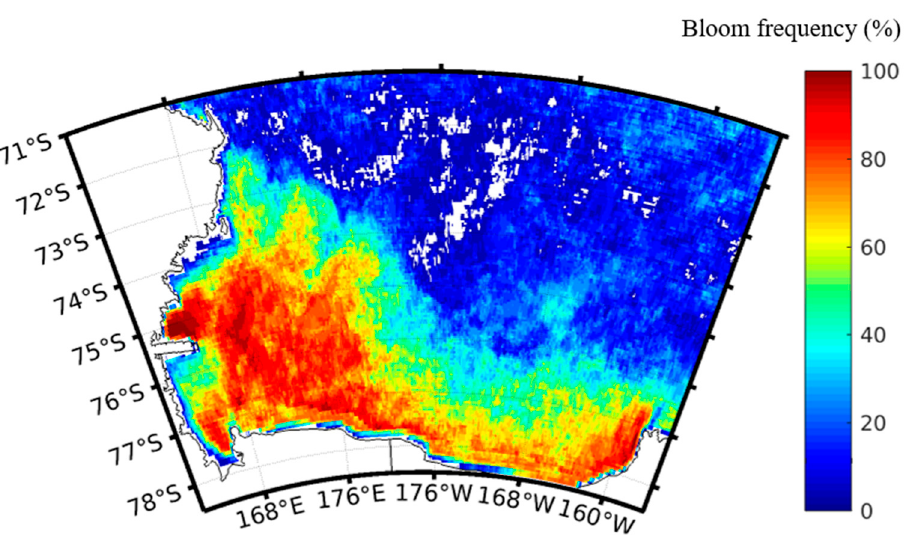
Figure 2. The spatial distribution of phytoplankton blooms in the Ross Sea in terms of bloom frequency between 2002 and 2021. Bloom frequency was quantified by dividing the total number of bloom observations by the total number of valid satellite observations, which was used to indicate the possibility of phytoplankton blooms to occur in a certain region. Phytoplankton blooms were defined with a Chl threshold of 2.0 mg m − 3 , based on the locally-tuned Chl algorithm. Note that the white gaps suggest few blooms ever occurred.